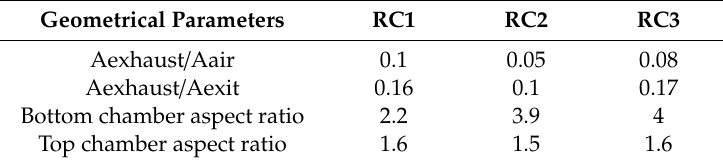
Table 1. Geometrical parameters of the tested regenerative